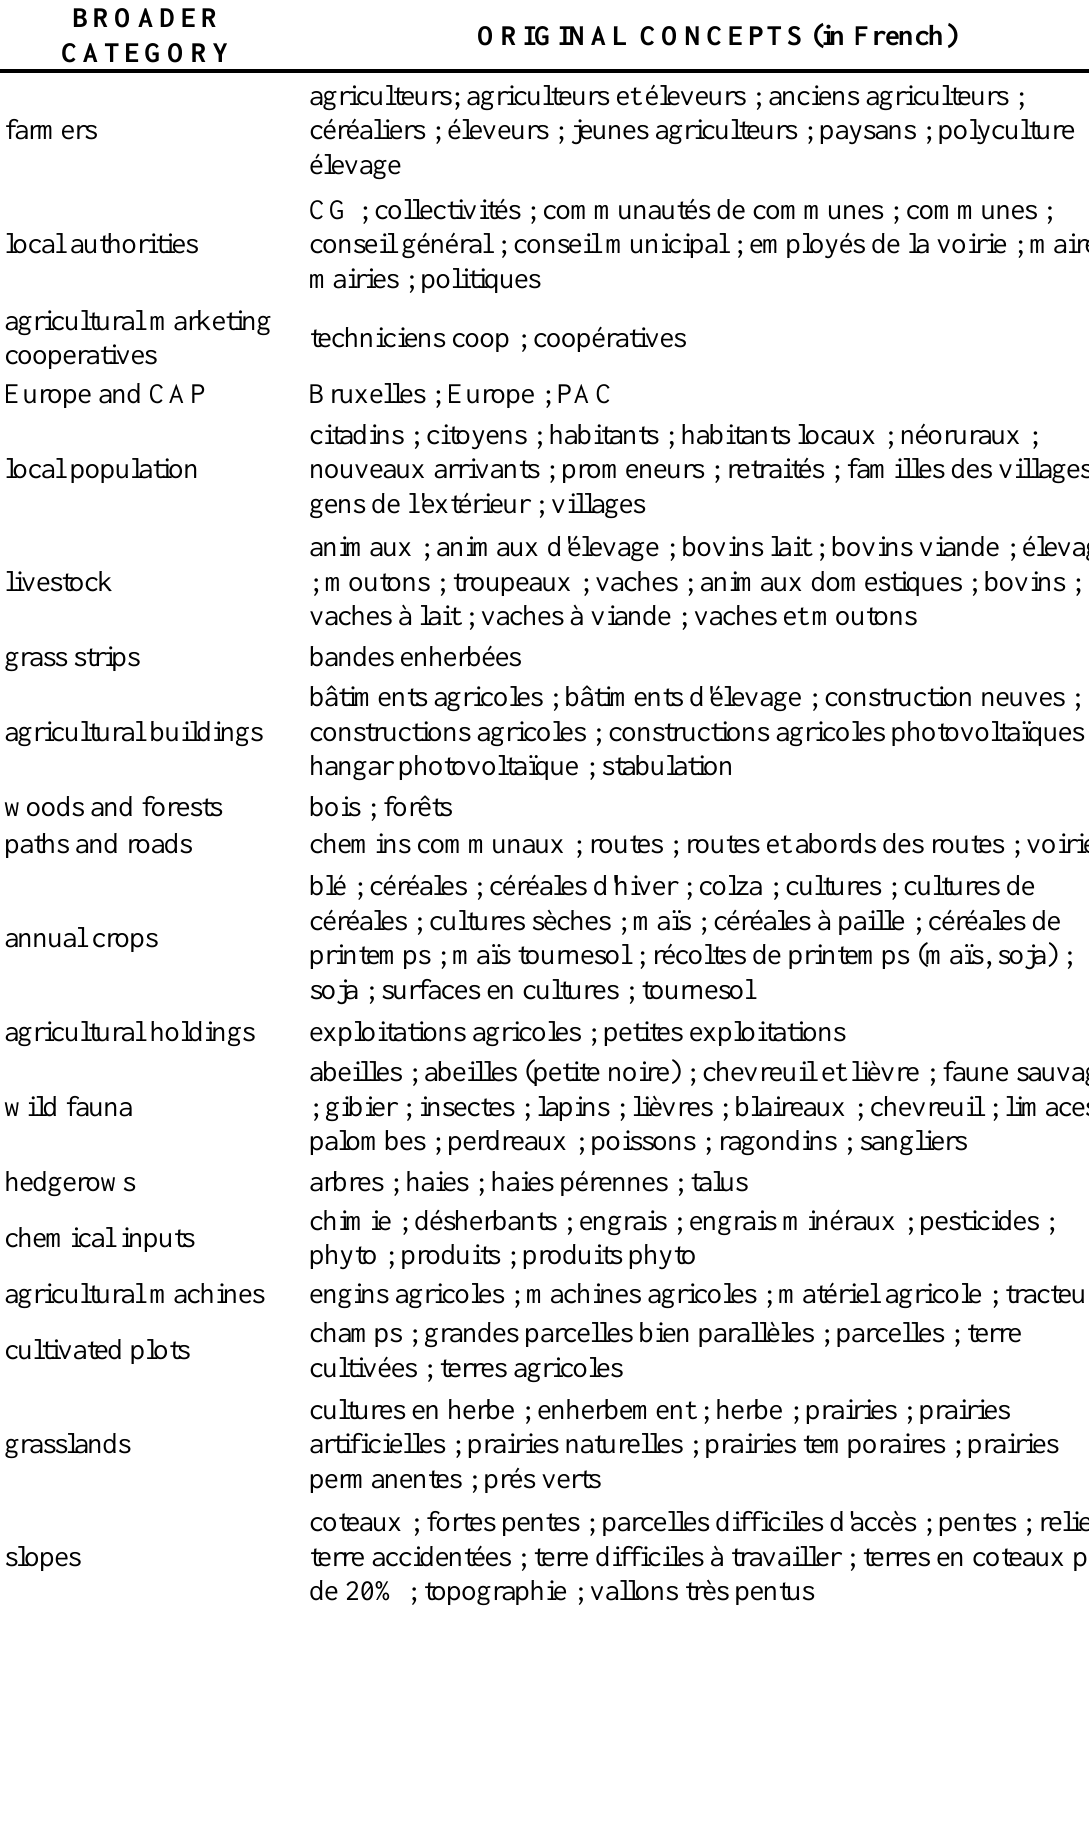
Table A2.1. Examples of the qualitative aggregation process: for each broader category, the original words uttered by farmers we included in this broader category are indicated (in